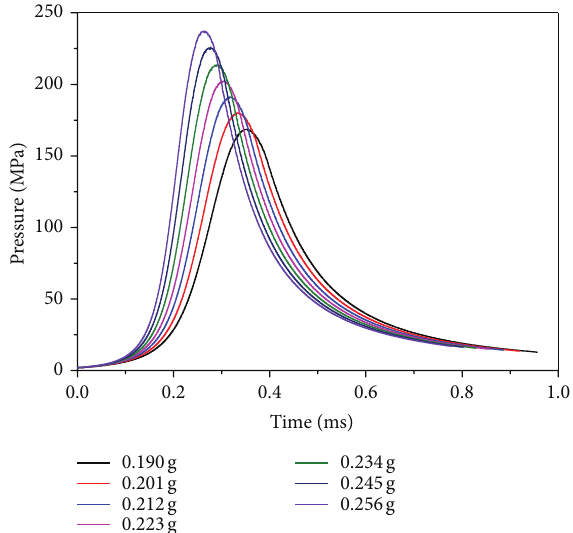
Figure 11: Shot base pressure-time history for 𝑚 𝑝 ∈ [0.190 g– 0.256 g].